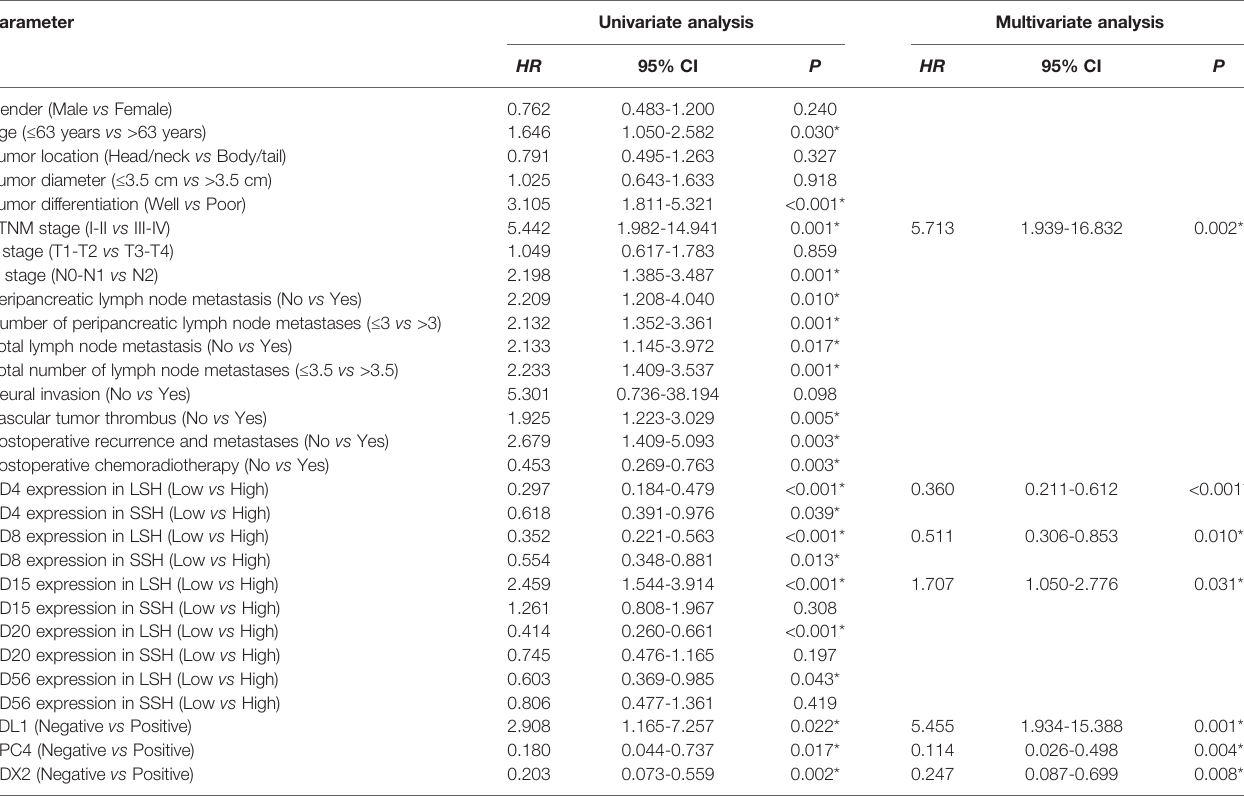
TABLE 3 | Univariate and multivariate analyses of the clinicopathological parameters and prognosis of PDAC patients in this study cohort.